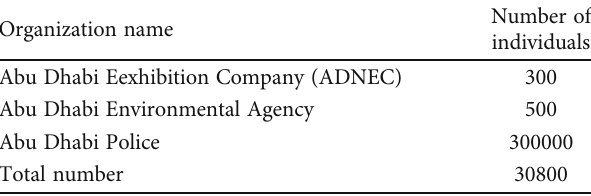
Table 1: Survey questionnaire sampling for employee ’ s perceptions of the IMS implementation practices inside the UAE public section institutions (UAEPSI).